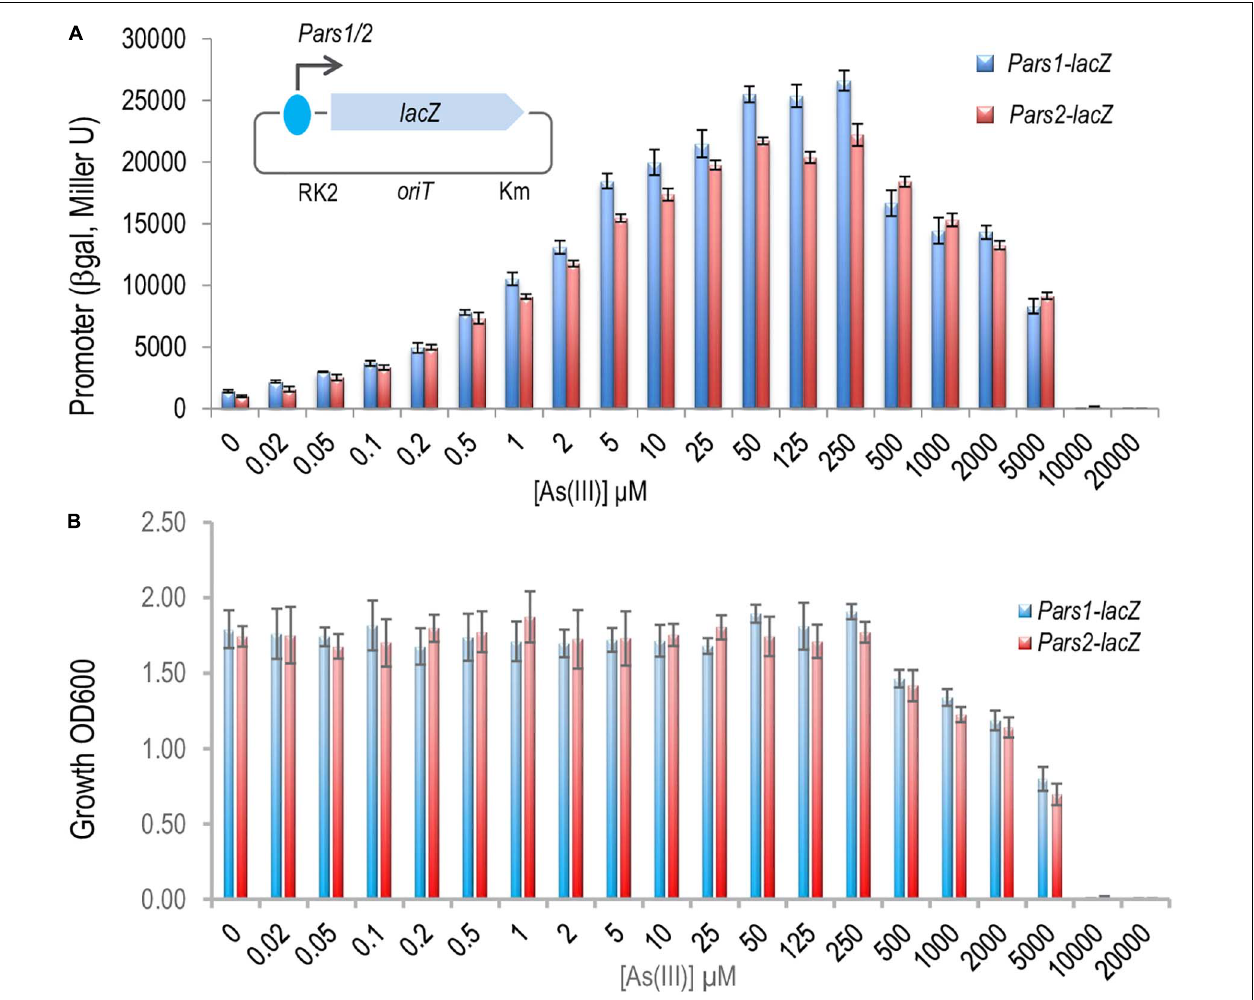
FIGURE 3 | In vivo effect of the arsenite on the regulation of the Pars1 and Pars2 promoters. (A) Pseudomonas putida KT2440 (containing a transcriptional fusions Pars1 -lacZ or Pars2 -lacZ in the plasmids pSEVA225- Pars1 or pSEVA225- Pars2 , respectively; see section “Materials and Methods”) was grown for 24 h at 30 ◦ C in LB medium with increasing concentrations of arsenite as indicated until the mid-exponential culture phase. β -galactosidase activity is expressed in Miller units. Results from three independent experiments ( n = 3) and errors bars are shown. (B) Toxic effect of arsenite in P. putida growth. P. putida KT2440 (containing the same transcriptional fusion plasmids) was grown for 24 h at 30 ◦ C in LB medium with increasing concentrations of arsenite as before. The cell growth was measured by spectrophotometry at 600 nm. Results from three independent experiments ( n = 3) and errors bars are